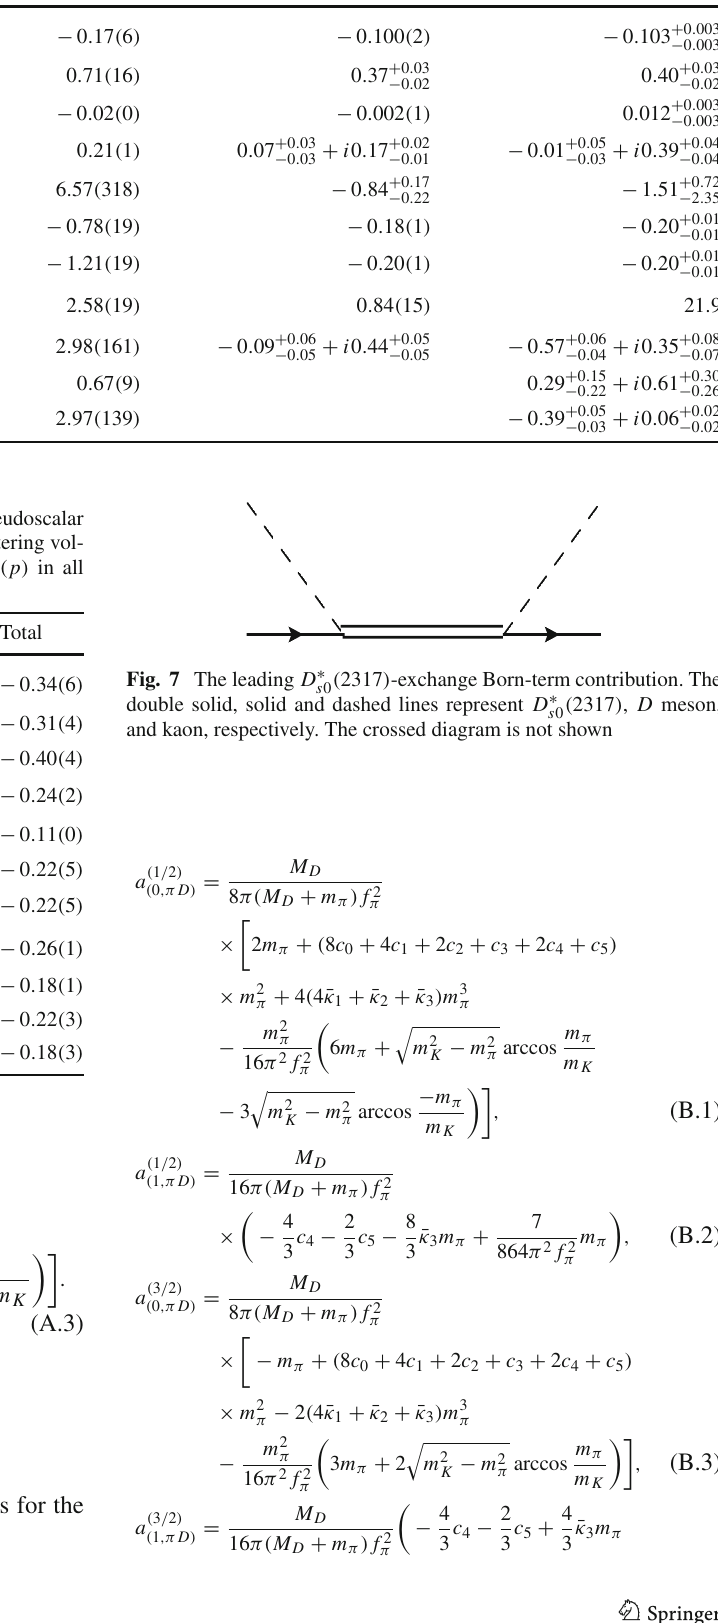
Table 3 Predictions of the scattering lengths for the light pseudoscalar meson and D meson at the physical meson values. The scattering lengths are in units of fm Sca. Len.